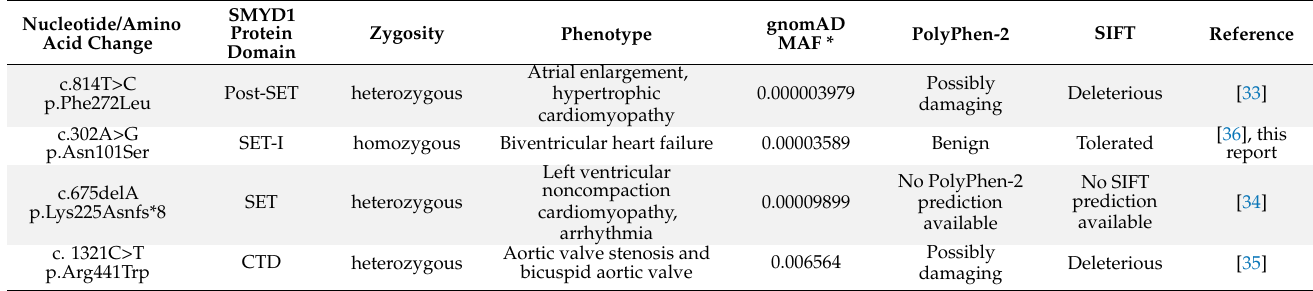
Table 4. Reported variants in the human SMYD1 gene identified in patients with cardiac